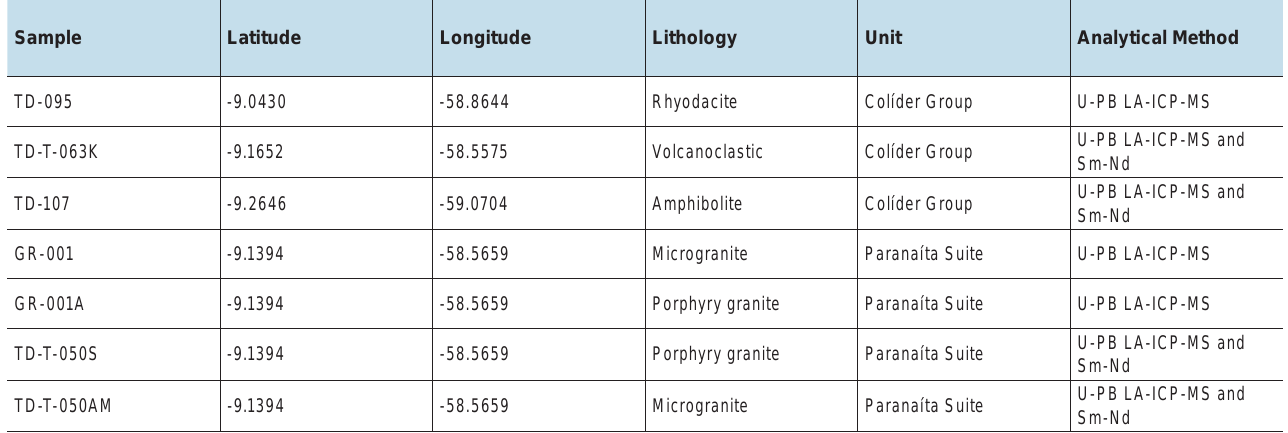
TABLE 2 - Information about the analyzed samples. Geographic coordinates in decimal degrees (WGS84)